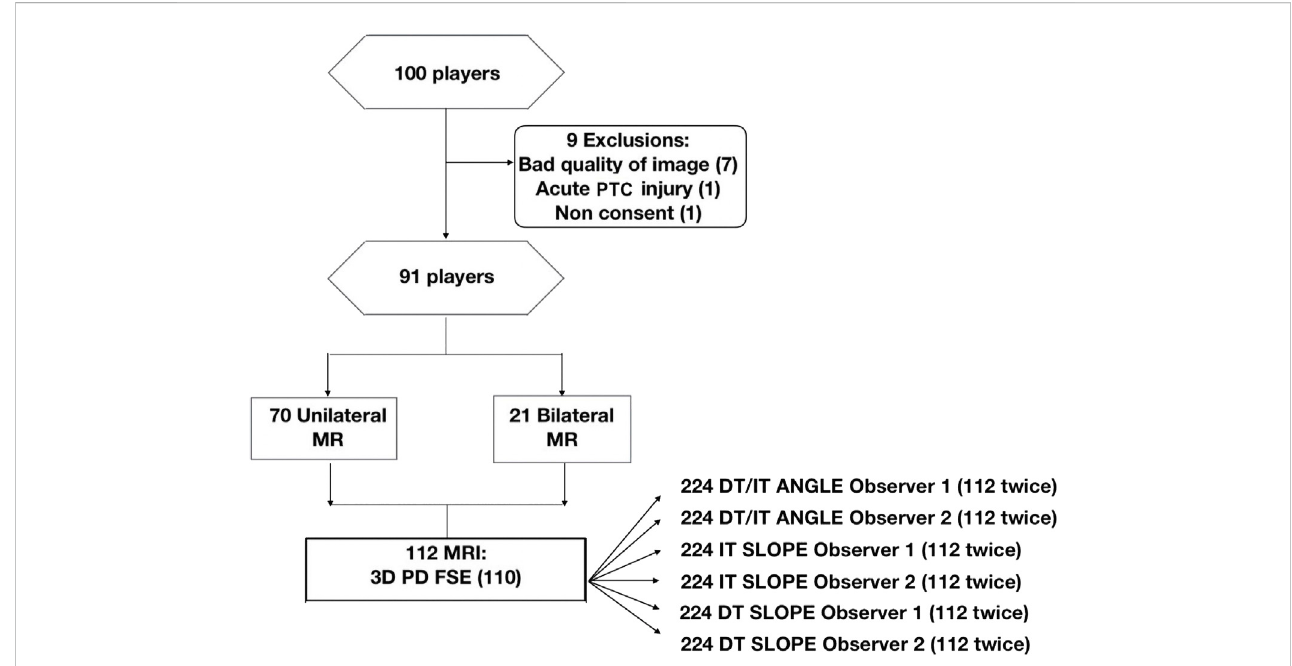
FIGURE 1 Flowchart of the participants in the study. DT, direct tendon; FSE, fast spin echo; IT, indirect tendon; PD, proton density; PTC, proximal tendon complex.